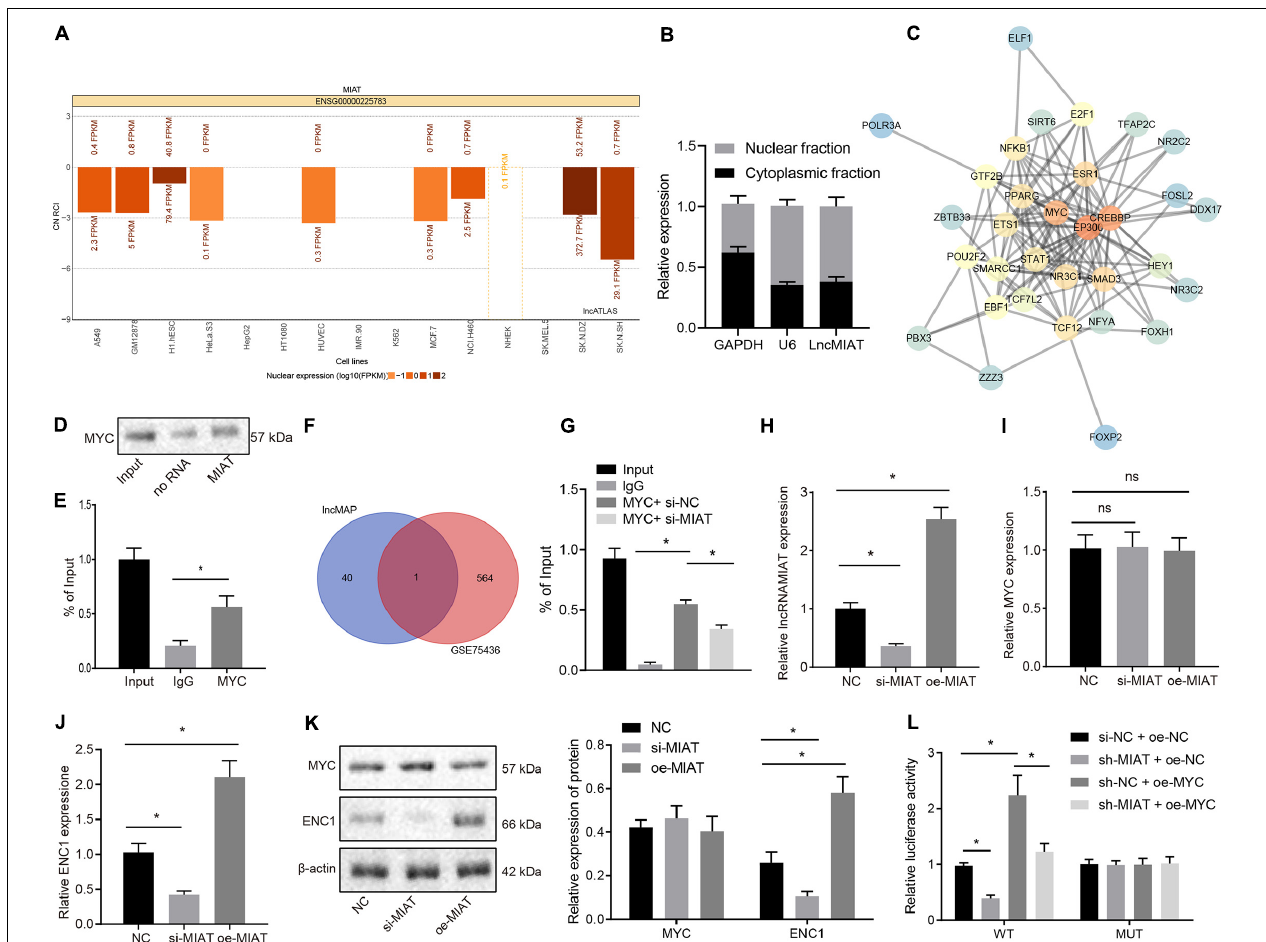
FIGURE 3 | MIAT upregulates ENC1 expression through MYC. (A) The subcellular localization of MIAT. CN RCI < 0 indicates that lncRNA is expressed in the nucleus, and CN RCI > 0 indicates that lncRNA is expressed in the cytoplasm. (B) After the nucleus and cytoplasm of HBEC-5i cells were separated, MIAT expression was detected by RT-qPCR. GAPDH was a marker of cytoplasm and U6 was a marker of nucleus. (C) The downstream TFs of MIAT analyzed by PPI analysis. The redder the color, the higher the core degree was Vice versa, the bluer the color, the lower the core degree was. (D) RNA pull down to detect the binding of MYC with MIAT. (E) RIP to detect the binding of MYC with MIAT. (F) The Venn map of the differentially expressed genes in the microarray GSE75436 and the downstream genes of TF MYC, and the intersection was ENC1. (G) The enrichment of MYC binding to the promoter region of ENC1 by ChIP. (H) MIAT expression in endothelial cells after overexpressing or silencing MIAT detected by RT-qPCR. (I) MYC mRNA expression in endothelial cells after overexpressing or silencing MIAT detected by RT-qPCR. (J) ENC1 expression in endothelial cells after overexpressing or silencing MIAT detected by RT-qPCR. (K) Protein expression of MYC and ENC1 in endothelial cells after overexpressing or silencing MIAT determined by Western blot analysis. (L) The regulatory effect on ENC1 by MIAT and MYC detected by dual luciferase reporter gene assay. * p < 0.05, ns p > 0.05. The measurement data were expressed as mean ± standard derivation, comparisons among multiple groups were analyzed by one-way ANOVA and followed by Tukey’s post hoc test, and the cell experiment was conducted three times